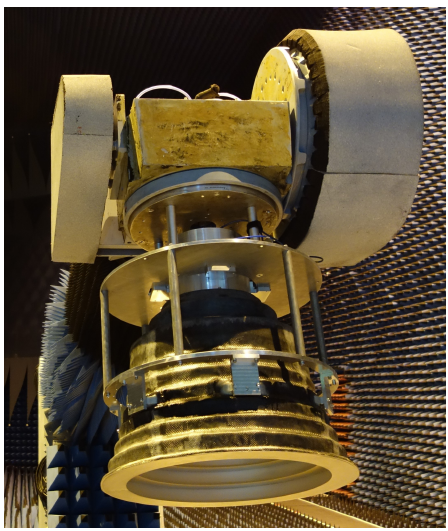
Figure 3. Lightweight carbon-reinforced-polymer (CFK) VEGA antenna mounted on the positioner of the DLR’s compact test range (CTR). During various measurement campaigns, the antenna pattern of the VEGA antenna on its own, as well as with additional modifications, was determined.